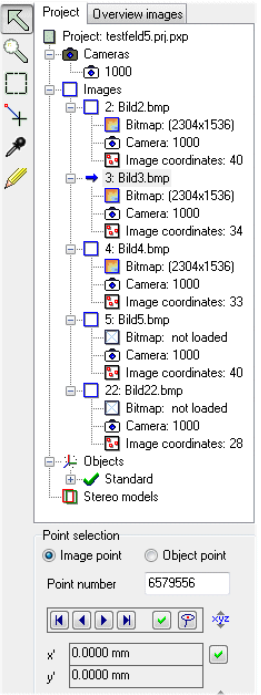
Figure 2: Project tree with images and objects